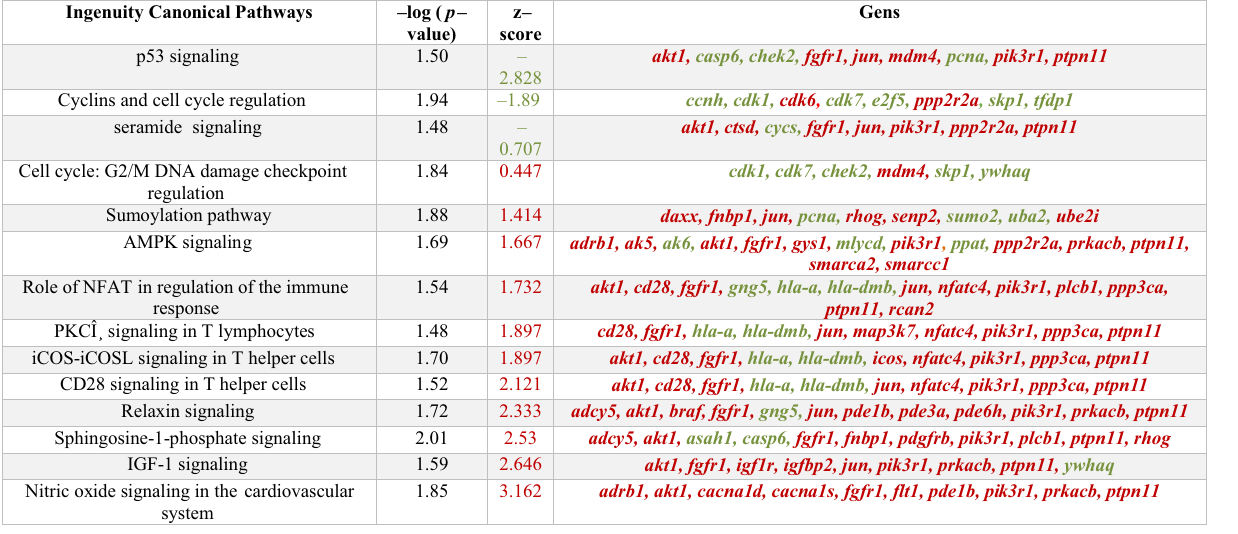
Table 1. Genes modulated by the variant 7292 versus the wild-type CNCM I-3690 and the major modulated pathways modulated by the variant 7292 as identified via Ingenuity pathway analysis software. Red color indicates upregulation, and green color